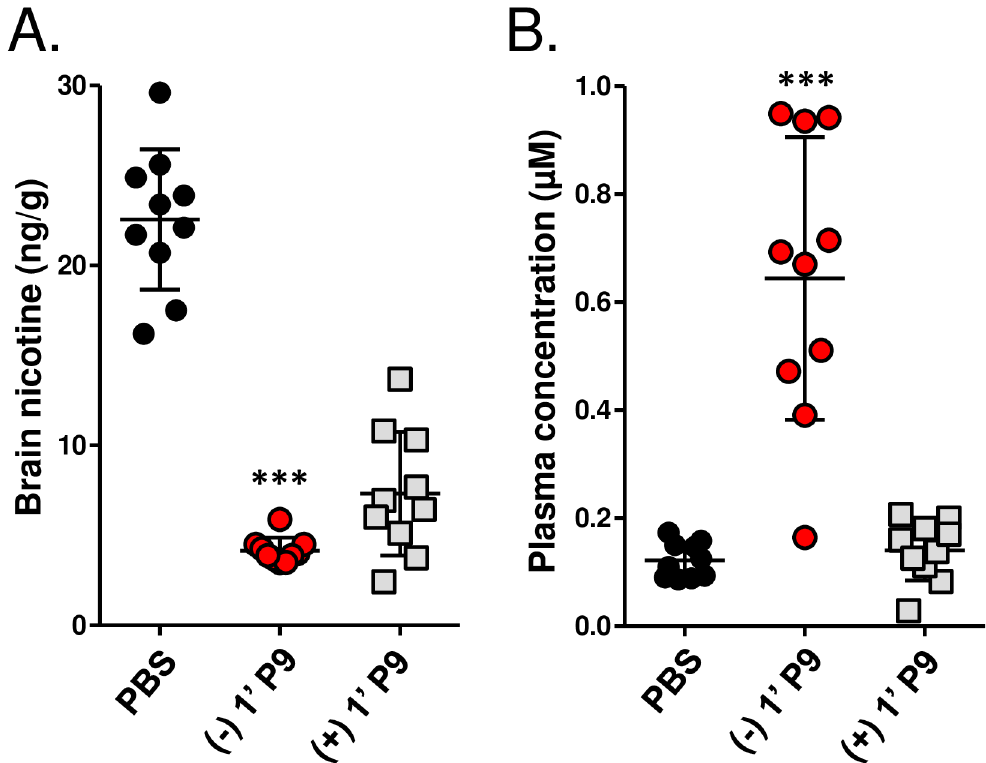
Fig 5. Vaccine efficacyis improved by using the natural (-) enantiomer of hapten 1’-SNic. Mice were immunized with 5 µ g (-) 1’ P9 or (+) 1’ P9 on days 0, 21 and 42. On day 70, mice were injected with an amount of nicotinetartrate equivalentto three cigarettes (0.05 mg/kg). Mice were sacrificedafter 5 minutes and nicotine levels were measuredin brain tissue (A) and sera (B) by LC-MS/MS. Comparisonsbetweengroupswere conductedone-wayANOVA. *** p < 0.01betweenvaccinatedgroups.